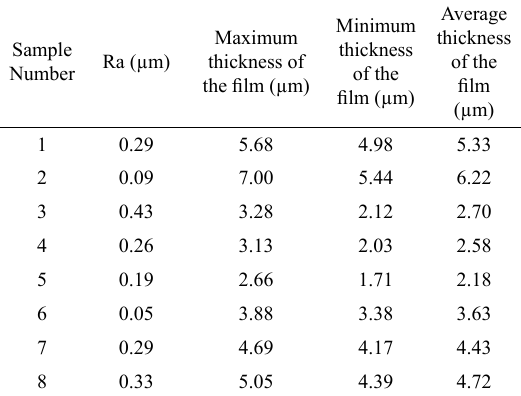
Table 2. Parameter Ra of the electrodeposited films on the steel substrate and the film